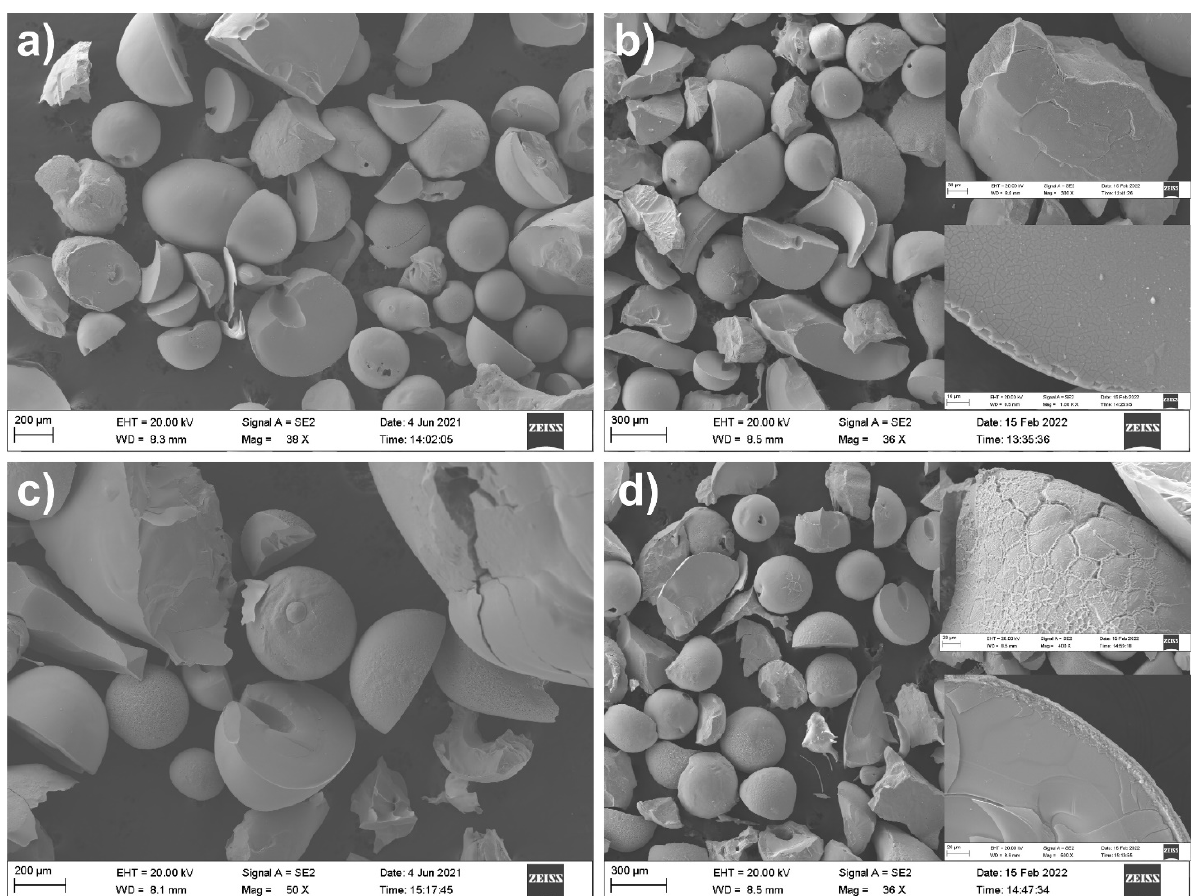
Figure 6. SEM images of sample surfaces for ZFS14-01 ( a ) before leaching and ( b ) after leaching at pH 5, and for ZFS14-10 ( c ) before leaching and ( d ) after leaching at pH 5.